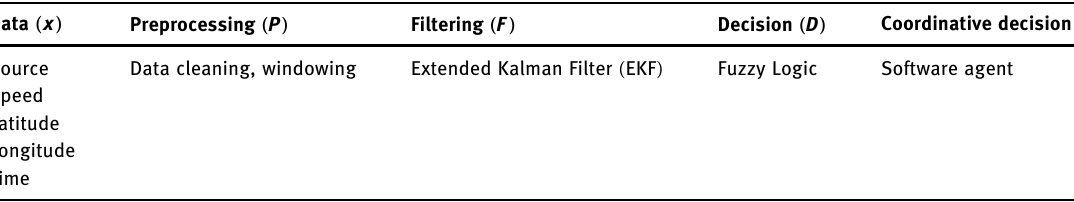
Table 3: Modelling and setting of the MCDFM framework